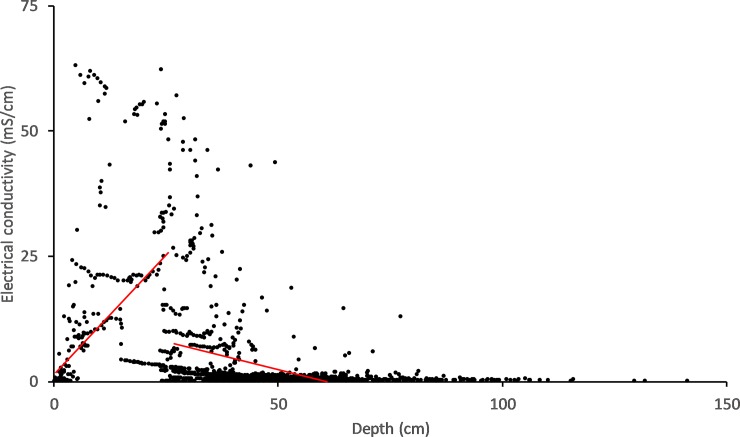
Piecewise visualisation of non-linear correlation between depth and EC.Red lines represent linear correlation segments from within the non-linear correlation. Here we can see increases in EC with Depth and decreases in EC with depth associated with tidal ingress and rainfall respectively.